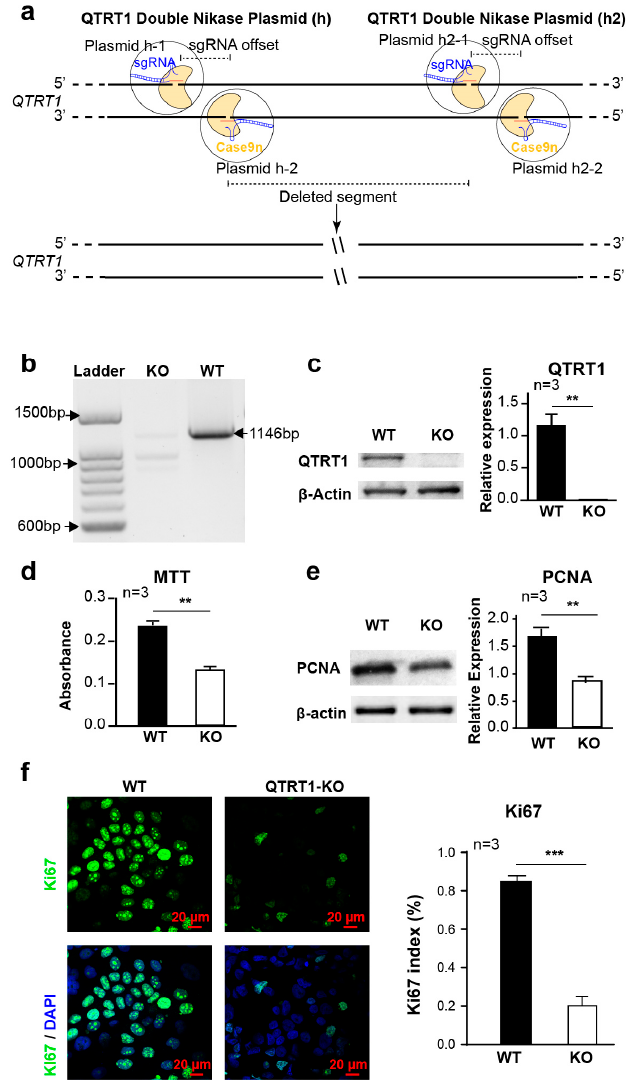
Figure 1. Knockout of Q tRNA ribosyltransferase catalytic subunit 1 (QTRT1) suppressed MCF7 breast cancer cell proliferation. ( a ) Schematic illustration of double-stranded DNA breaks using a pair of Cas9 D10A nickases (Cas9n). ( b ) The deletion of QTRT1 in MCF7 cells was confirmed using PCR with primers specific for the QTRT1 gene. ( c ) Western blot analysis of wildtype (WT), QTRT1-knockout (KO) MCF7 cells generated using Double Nickase Plasmids after treating for 72 h. Mean ± SD, n = 3; ** p -value < 0.01, two-tailed Welch’s t -test. ( d ) MTT assay to show cell proliferation of WT and QTRT1-KO MCF7 conducted at 48 h after seeding the same number of cells. Mean ± SD, n = 3; ** p -value < 0.01, two-tailed Welch’s t -test. ( e , f ) Cell proliferation markers of PCNA (proliferating cell nuclear antigen) and Ki67 in WT and QTRT1-KO MCF7 cells were detected using Western blot (E) and immunofluorescence staining (F), respectively. Immunofluorescence staining of Ki67 and DAPI were performed in the cells, and Ki67 index (Ki67 stained cells / total cells) was calculated. Mean ± SD, n = 3; ** p -value < 0.01, *** p -value < 0.001, two-tailed Welch’s t